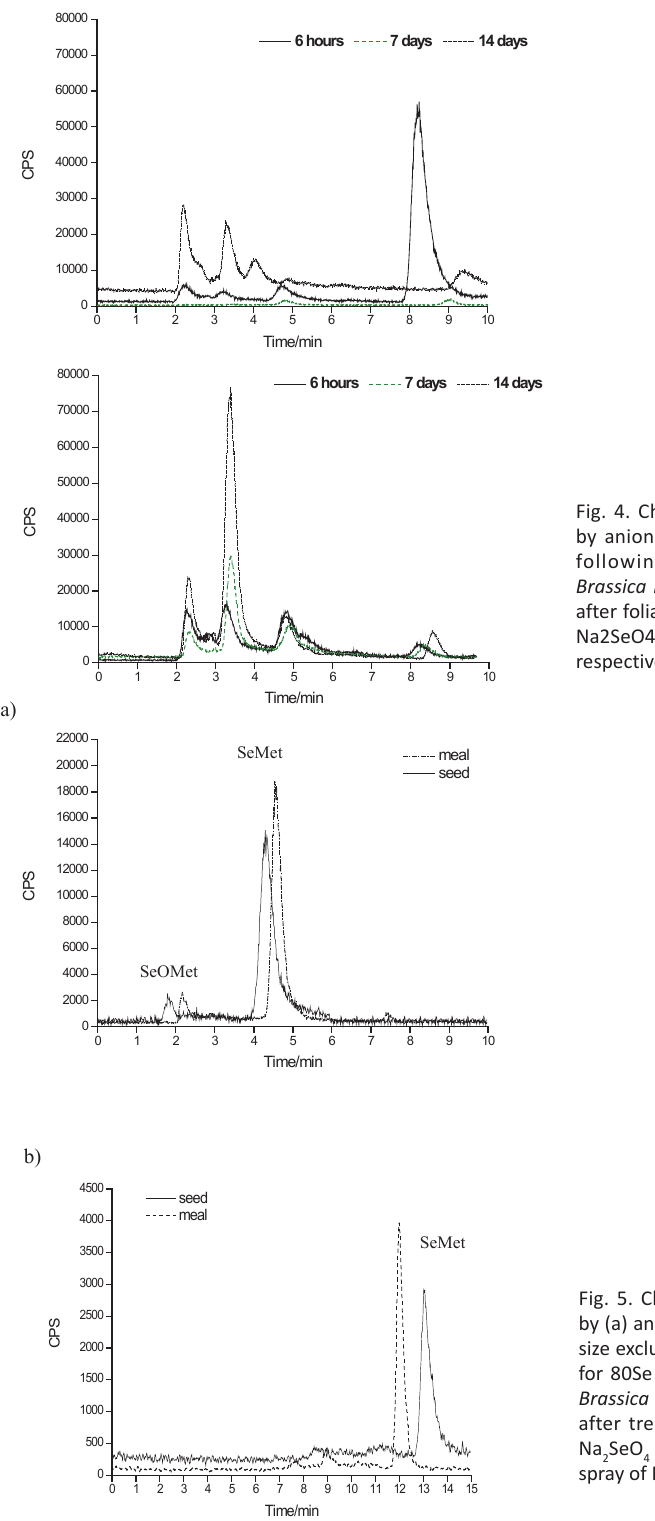
Fig. 5. Chromatographic profiles obtained by (a) anion exchange HPLC-ICP-MS and (b) size exclusion anion exchange HPLC-ICP-MS for 80Se following enzymatic extraction of Brassica napus meal and seeds from plants after treatment with 130 µg Se plant -1 as Na SeO in soil and 30 µg Se plant -1 , foliar 2 4 spray of Na SeO ; 2 4